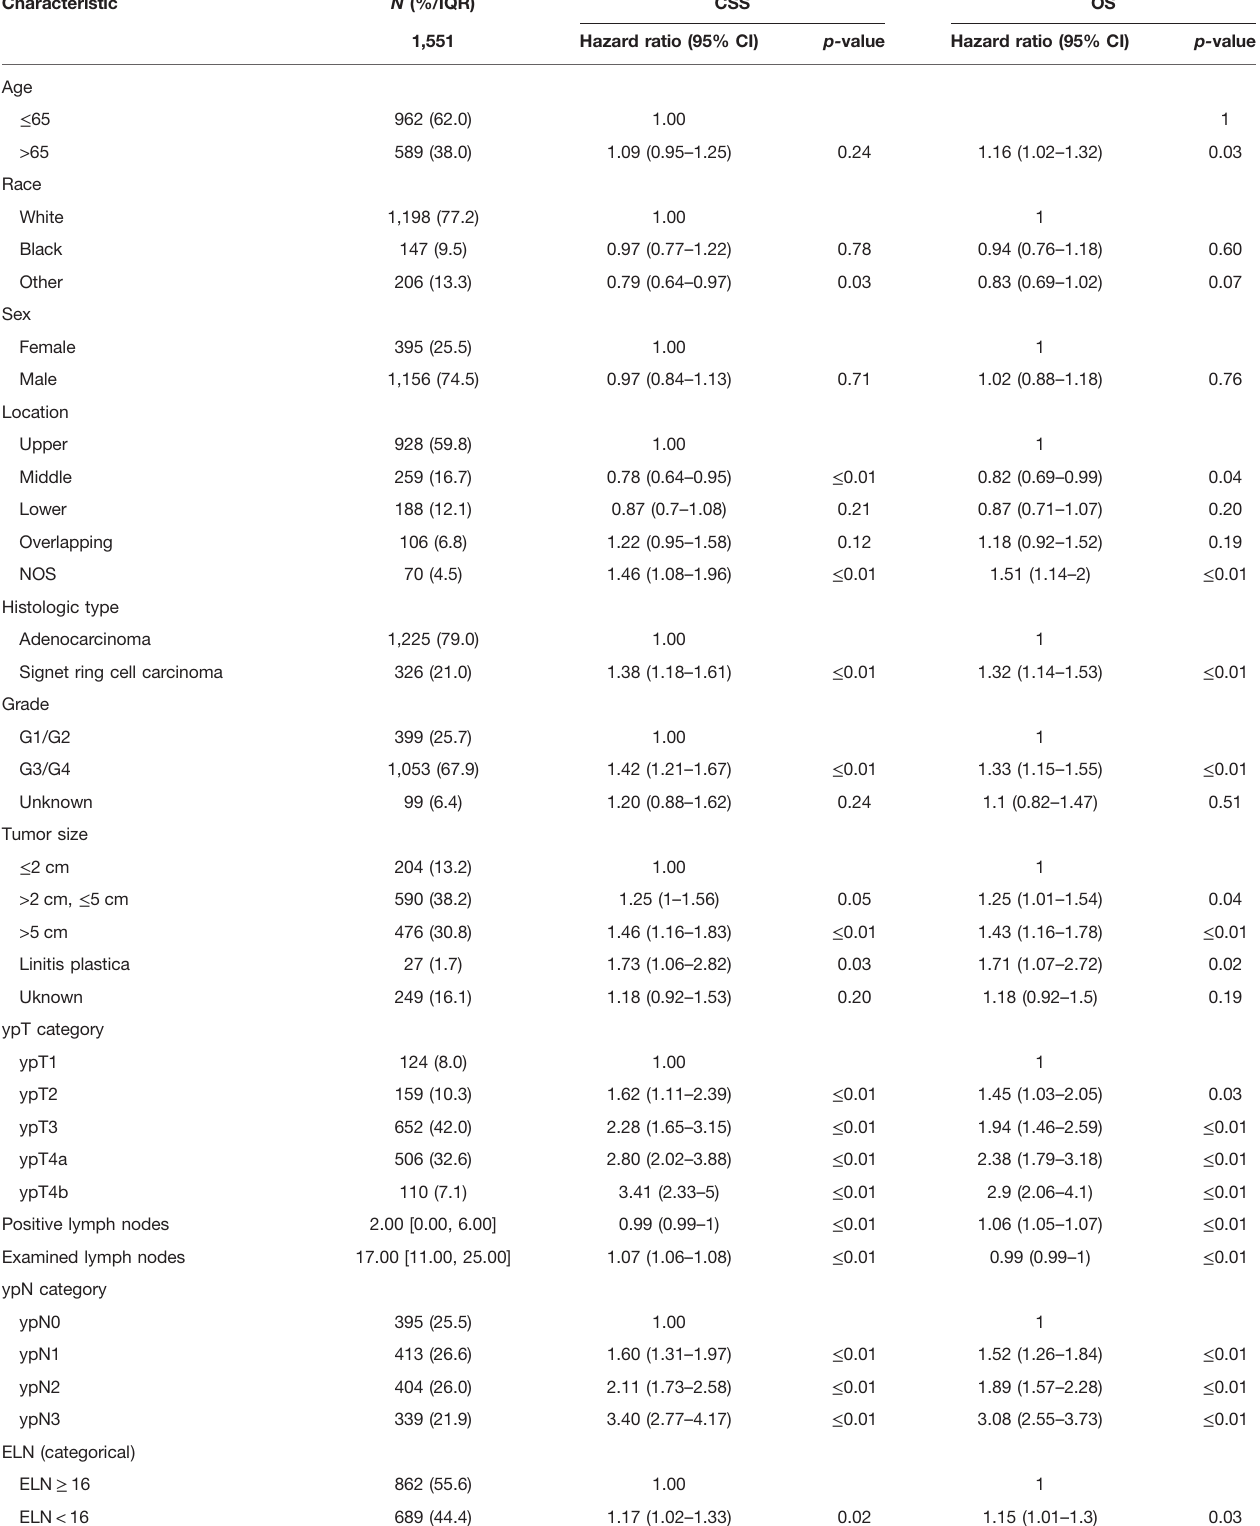
TABLE 1 | Baseline characteristics and univariate analysis for CSS and OS in gastric adenocarcinoma patients after